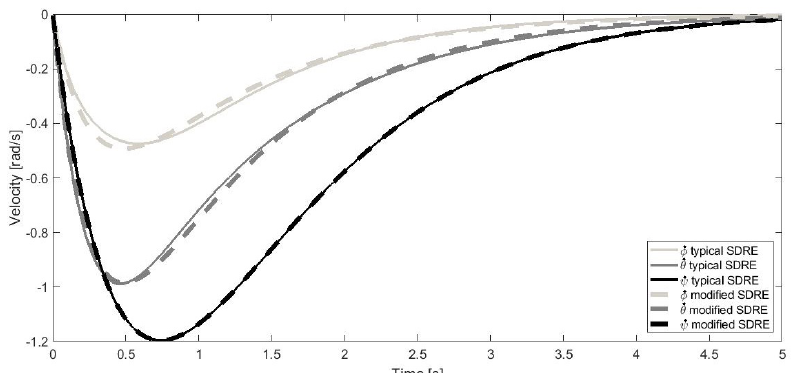
Figure 2. Time plot of angles.